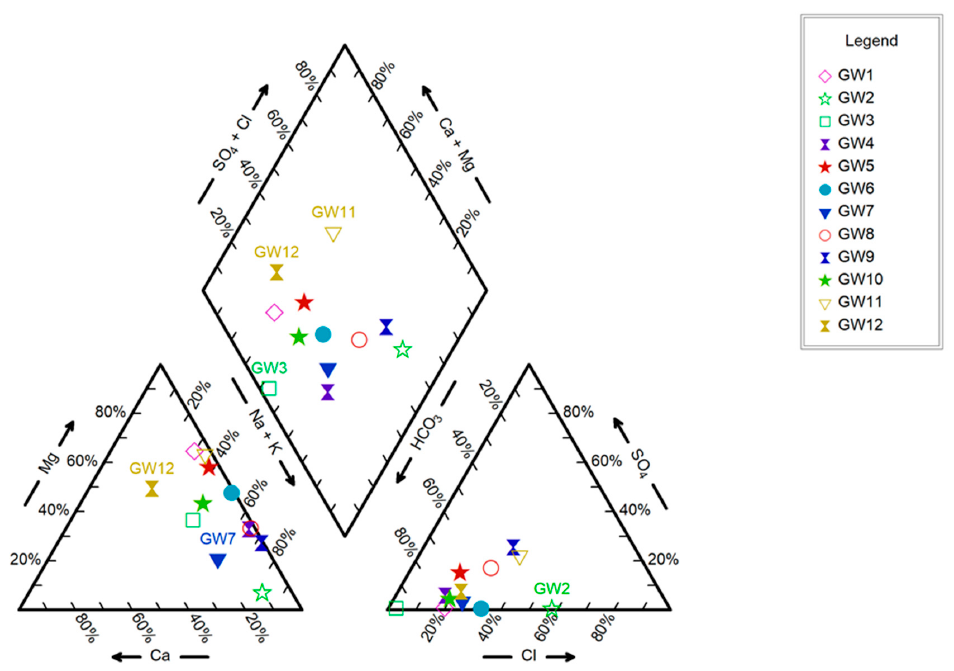
Figure 7. Piper diagram of 12 groundwater samples in the study area.